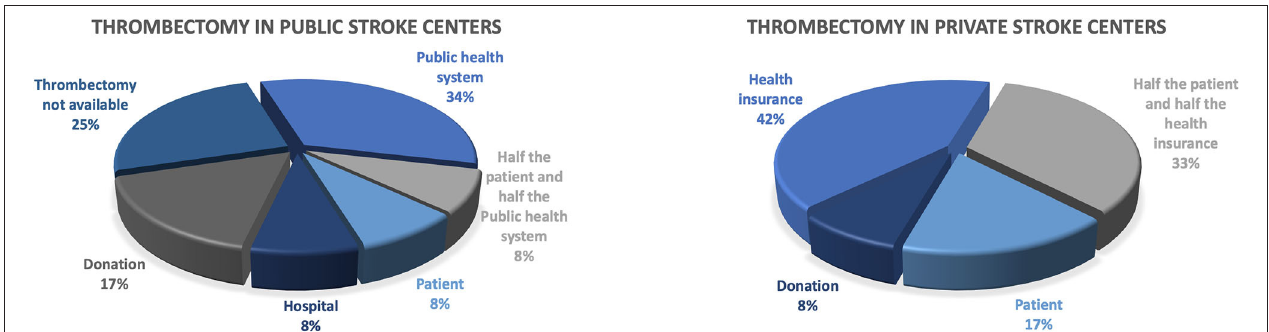
FIGURE 3 | Who pays for mechanical thrombectomy?